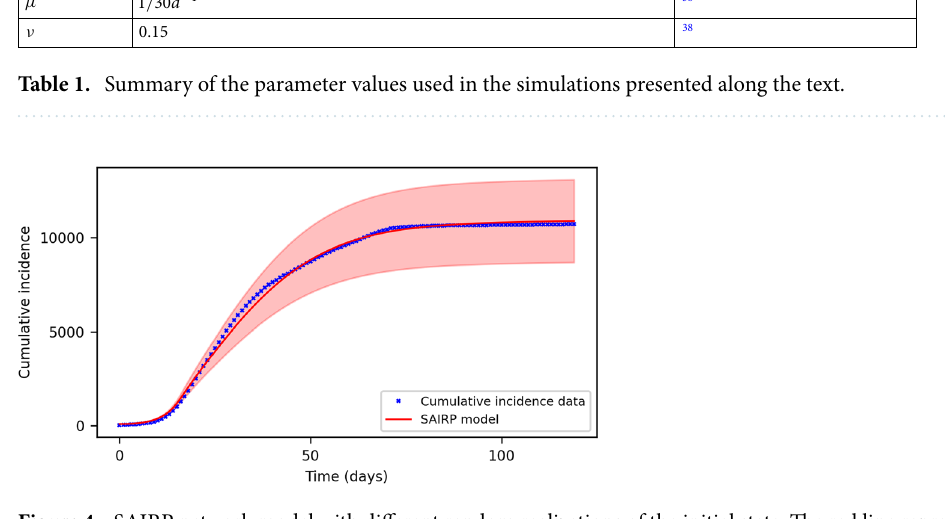
Figure 4. SAIRP network model with different random realizations of the initial state. The red line represents the mean value of the cumulative incidence over the whole number of carried simulations, while the red shadow represents the standard deviation of the